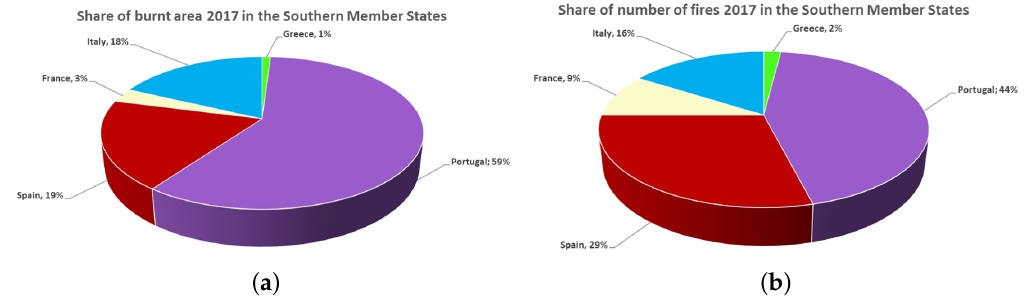
Figure 1. Share of the total burnt area ( a ) and the total number of fires ( b ) in each of the Southern Member States for 2017